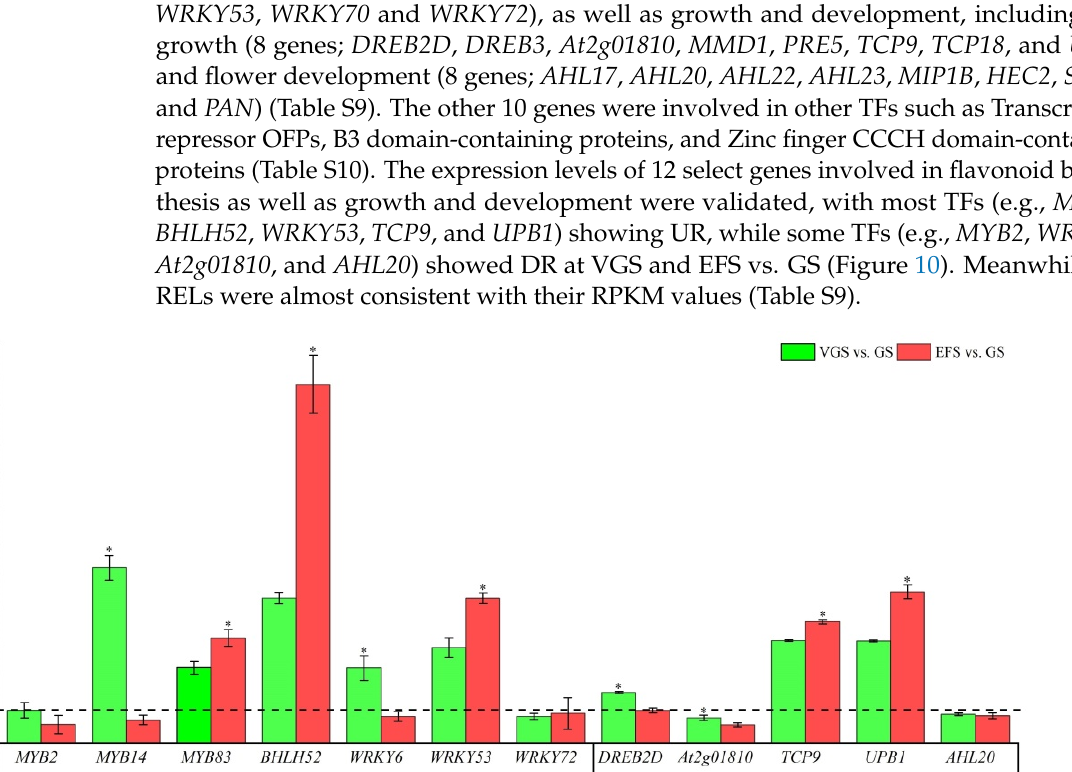
Figure 11. The relative expression level of genes involved in polysaccharide transport at VGS and EFS vs. GS, as determined by qRT-PCR (mean ± SD, n = 3). The “*” represents a significant differ- ence ( p < 0.05) at different growth stages for the same gene. 2.5.7. DEGs Involved in Other Biological Functions In this study, there are 126 DEGs involved in other biological functions, including: photosynthesis and energy (43 genes; Table S13), polynucleotide metabolism (29 genes; Table S14), protein metabolism (23 genes; Table S15), and stress response (31 genes; Ta-